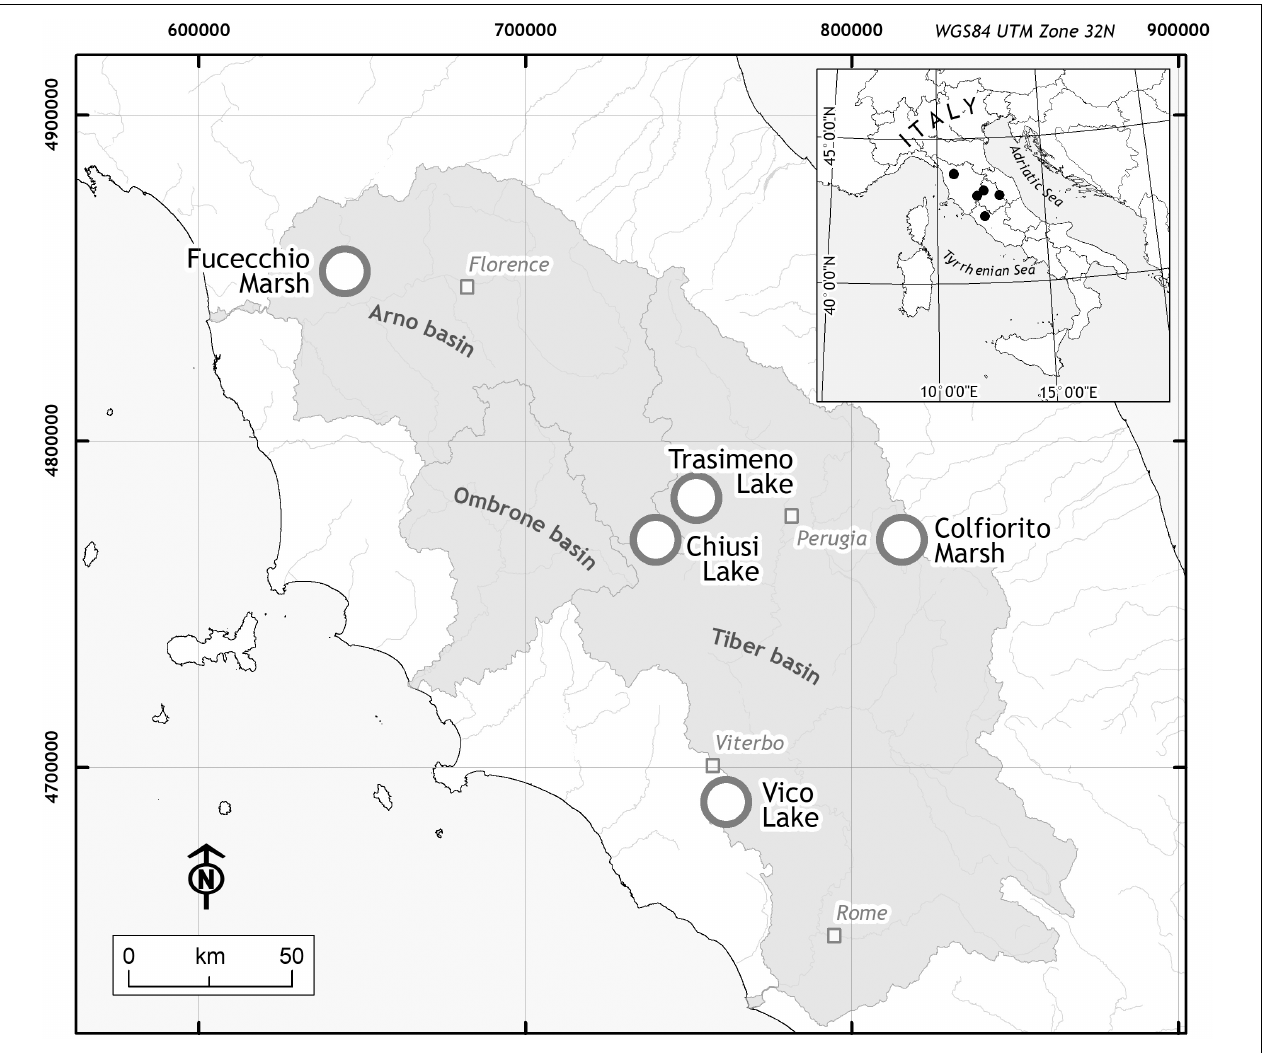
FIGURE 1 | Locations of the study area. The five sampling sites (white dot) were located in three Italian Regions: Tuscany for Fucecchio Marsh (‘ Fu ’) and Chiusi Lake (‘ Ch ’); Umbria for Colfiorito Marsh (‘ Co ’) and Trasimeno Lake (‘ Tr ’); Latium for Vico Lake (‘ Vi